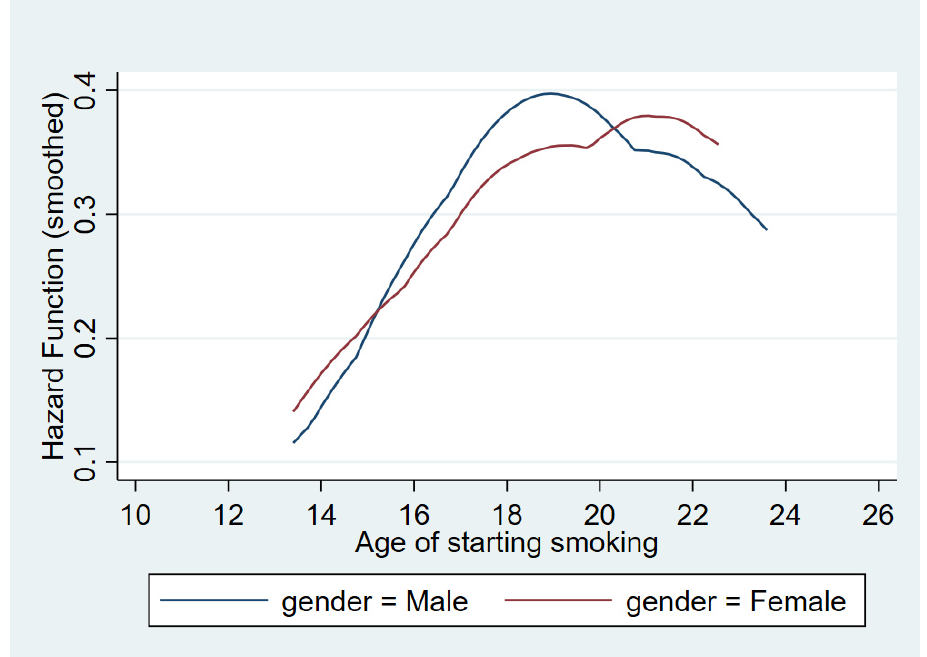
Figure 1. Hazard of initiating a tobacco addiction. Source: Authors’ calculations.